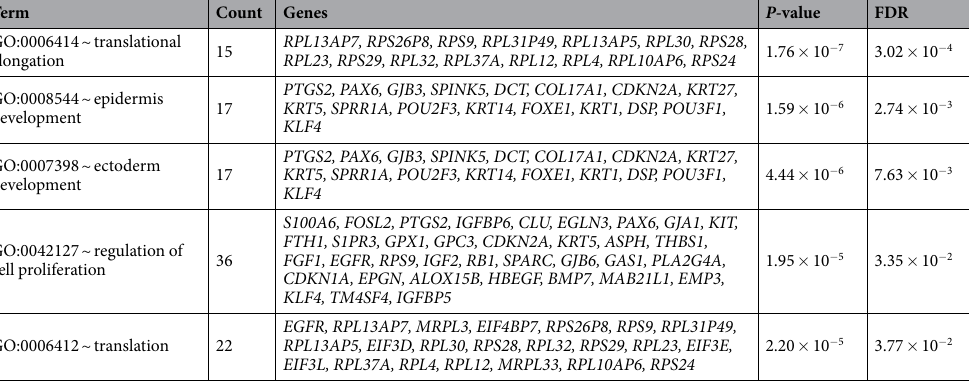
Table 1. Gene ontology enrichment analysis of genes highly expressed in K + Y-treated LECs. FDR: false discovery rate <